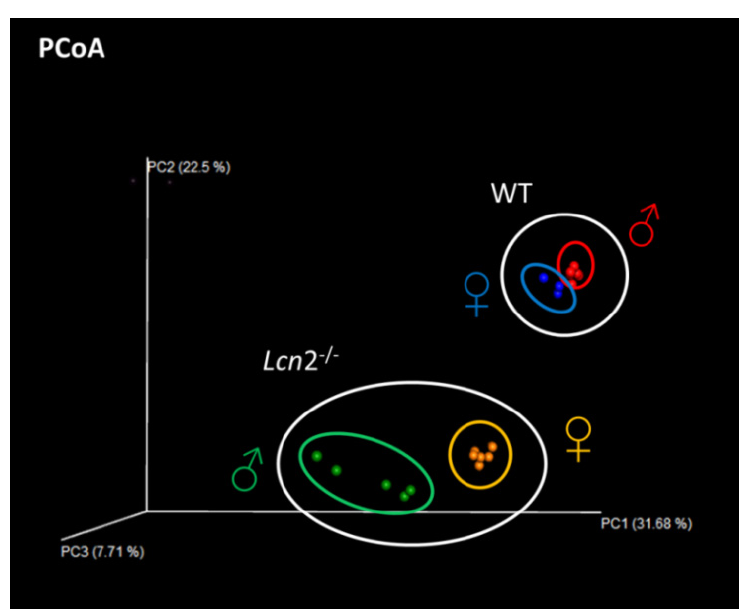
Figure 3. Principal coordinates analysis (PCoA) of the intestinal tract microbial community. Depicted are the unweighted UniFrac distance metrics between microbial communities of the intestinal tract of Lcn2 -/- and WT mice of both sexes. The three-dimensional visualization of the sequencing data was performed with the EMPeror software. Each point represents a single sample that is displayed in the same color within a group.